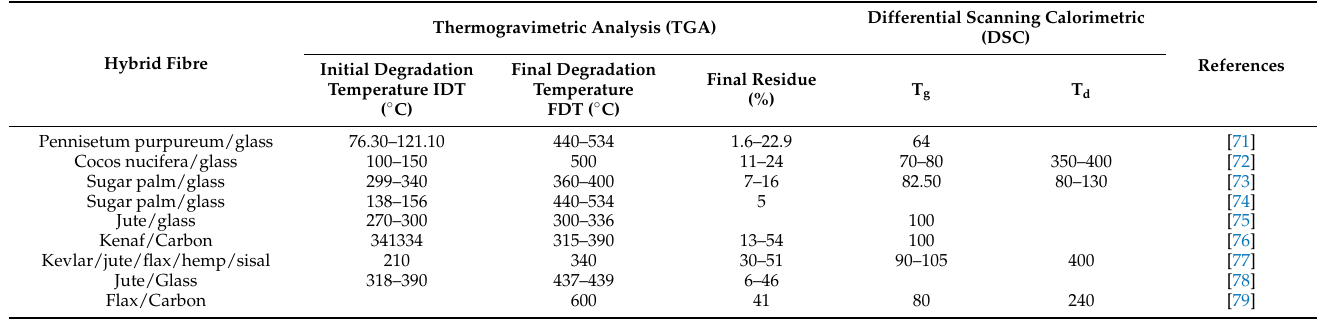
Table 6. Thermal studies from several